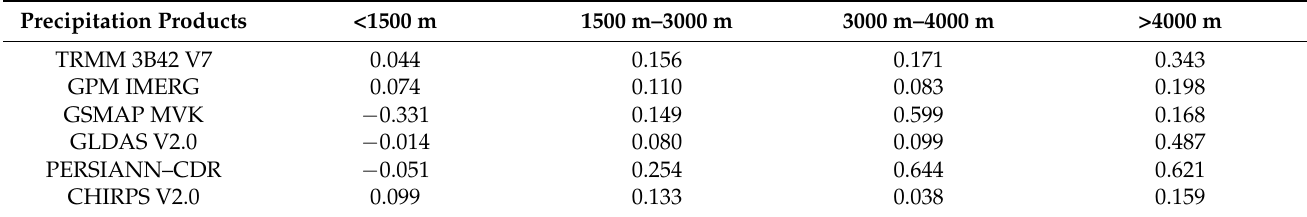
Table 7. Bias between different elevation